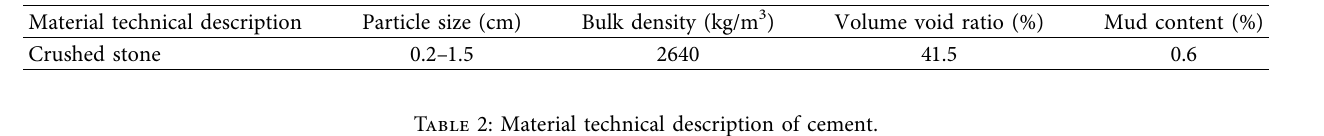
Table 1: Material technical description of crushed stone.